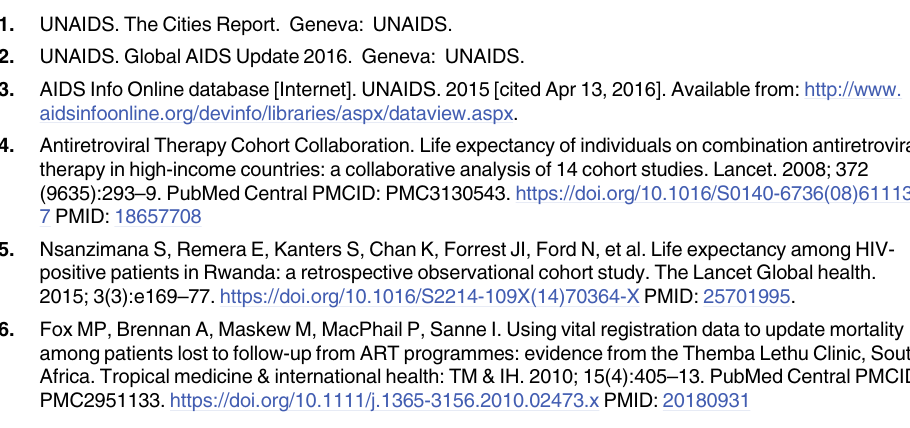
S3 Table. Simulation results for overall and sex-specific standardized mortality ratio (SMR) and population attributable fraction (PAF), Nairobi